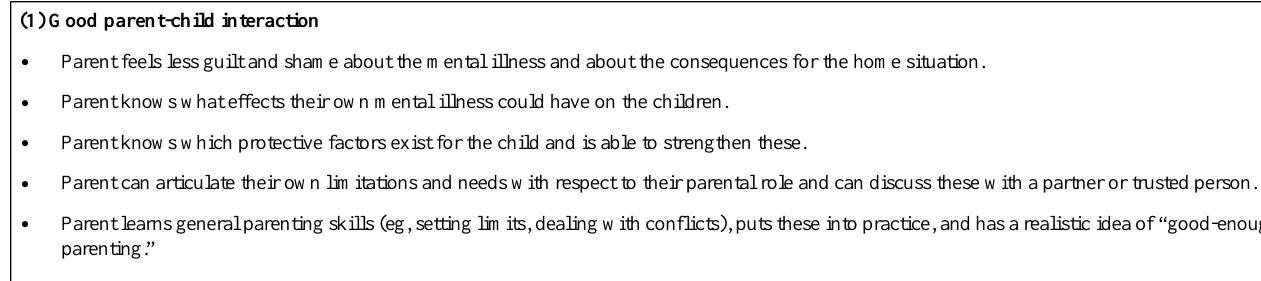
Textbox 1. Objectives of the online KopOpOuders course and their operational